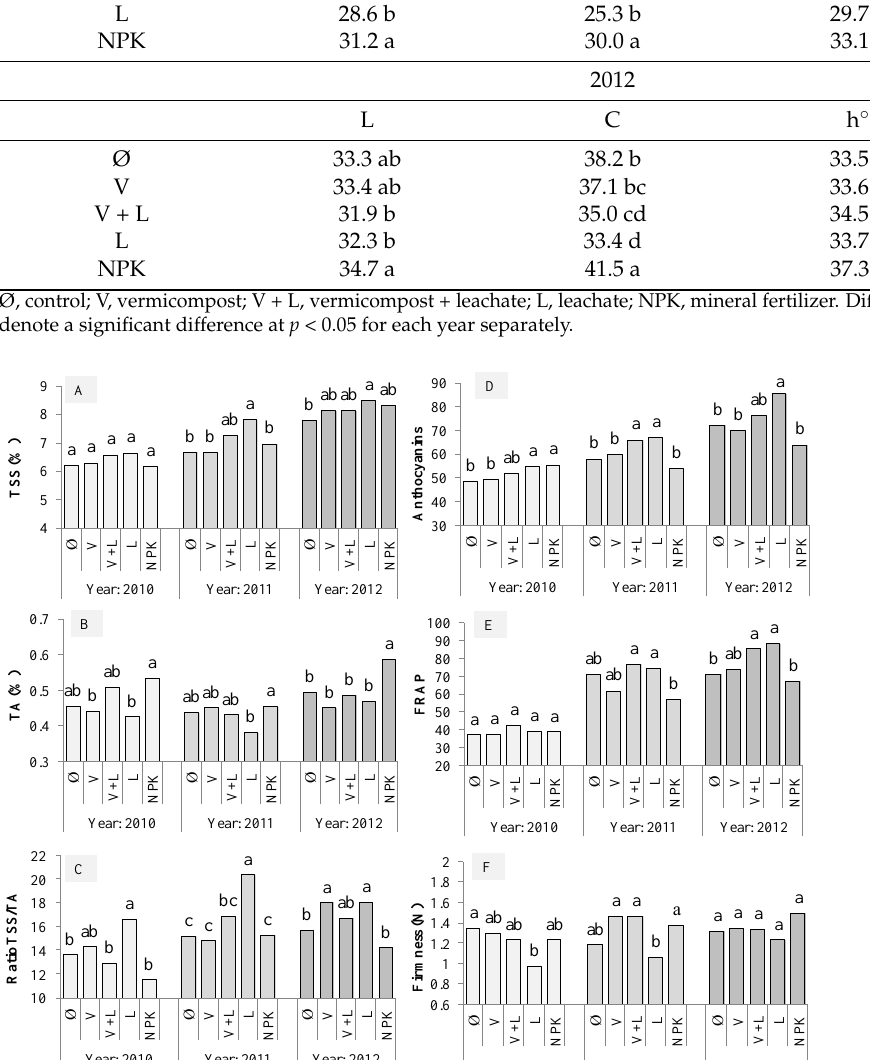
Figure 3. The concentration of total soluble solids (TSS) ( A ), total acids (TA) ( B ) and the ratio between TSS and TA ( C ), anthocyanins (mg cyanidin-3-glucoside/100 g of fruit) ( D ), antioxidant activity (FRAP units) ( E ), and the firmness of strawberry fruit ( F ). Ø, control; V, vermicompost; V + L, vermicompost + leachate; L, leachate; NPK, mineral fertilizer. Different letters denote a significant difference at p < 0.05 for each year separately.